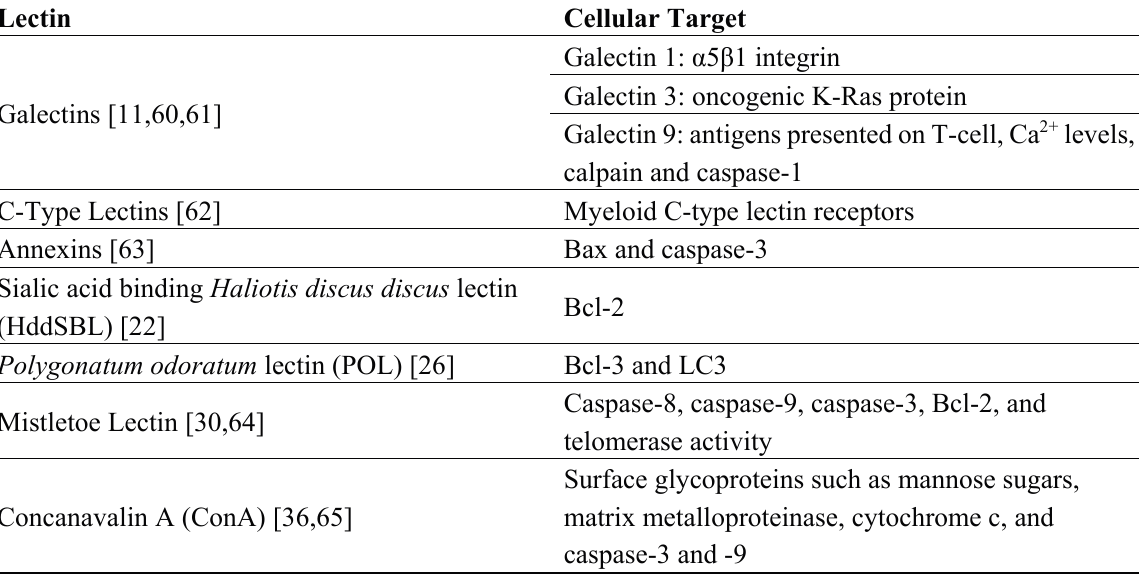
Table 2. Cellular targets of lectins leading to